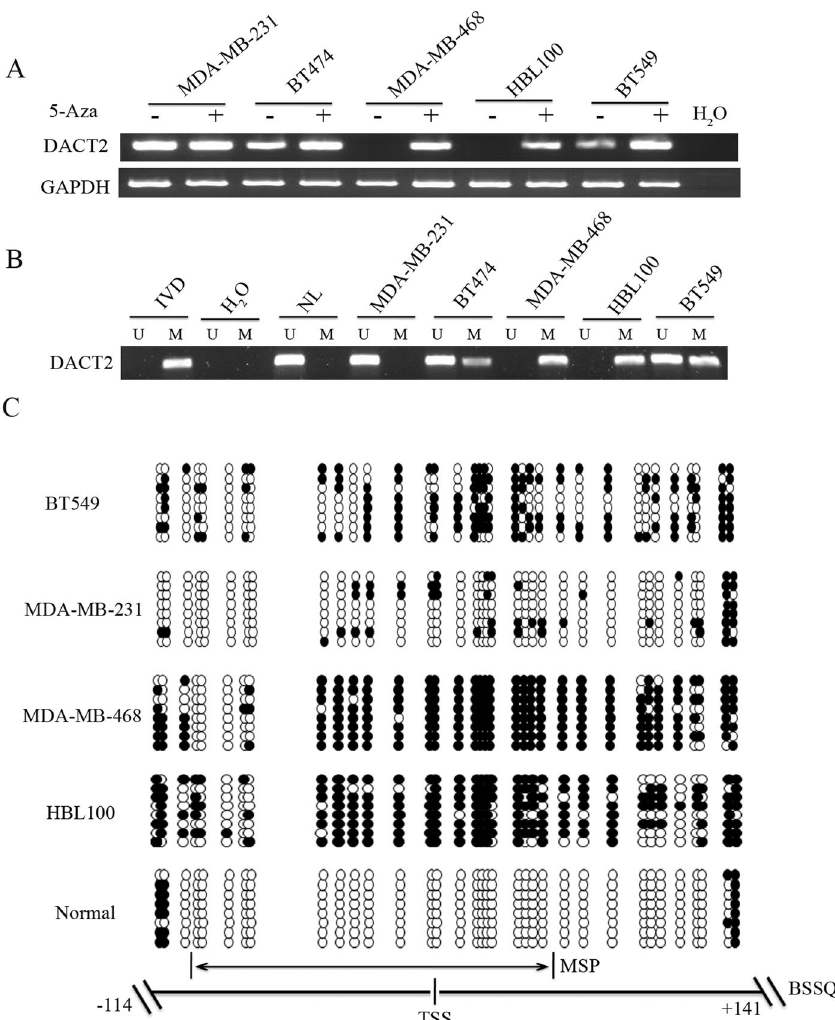
Figure 1. Expression of DACT2 was silenced by DNA methylation in breast cancer cell lines ( A ) RT-PCR shows the levels of DACT2 expression. MDA-MB-231, BT474, MDA-MB-468, HBL100 and BT549 are breast cancer cell lines. ( − ) untreated; ( + ) 5-Aza treated; H 2 O: double distilled water. GAPDH was used as an internal control. ( B ) MSP results of DACT2 in breast cancer cell lines. IVD: in vitro methylated DNA; NL: normal lymphocyte DNA; M: methylated alleles; U: unmethylated alleles. ( C ) Bisulfite sequencing results: Double- headed arrow indicates the region of the MSP product. Filled circles: methylated CpG sites; open circles: unmethylated CpG sites. TSS: transcription start